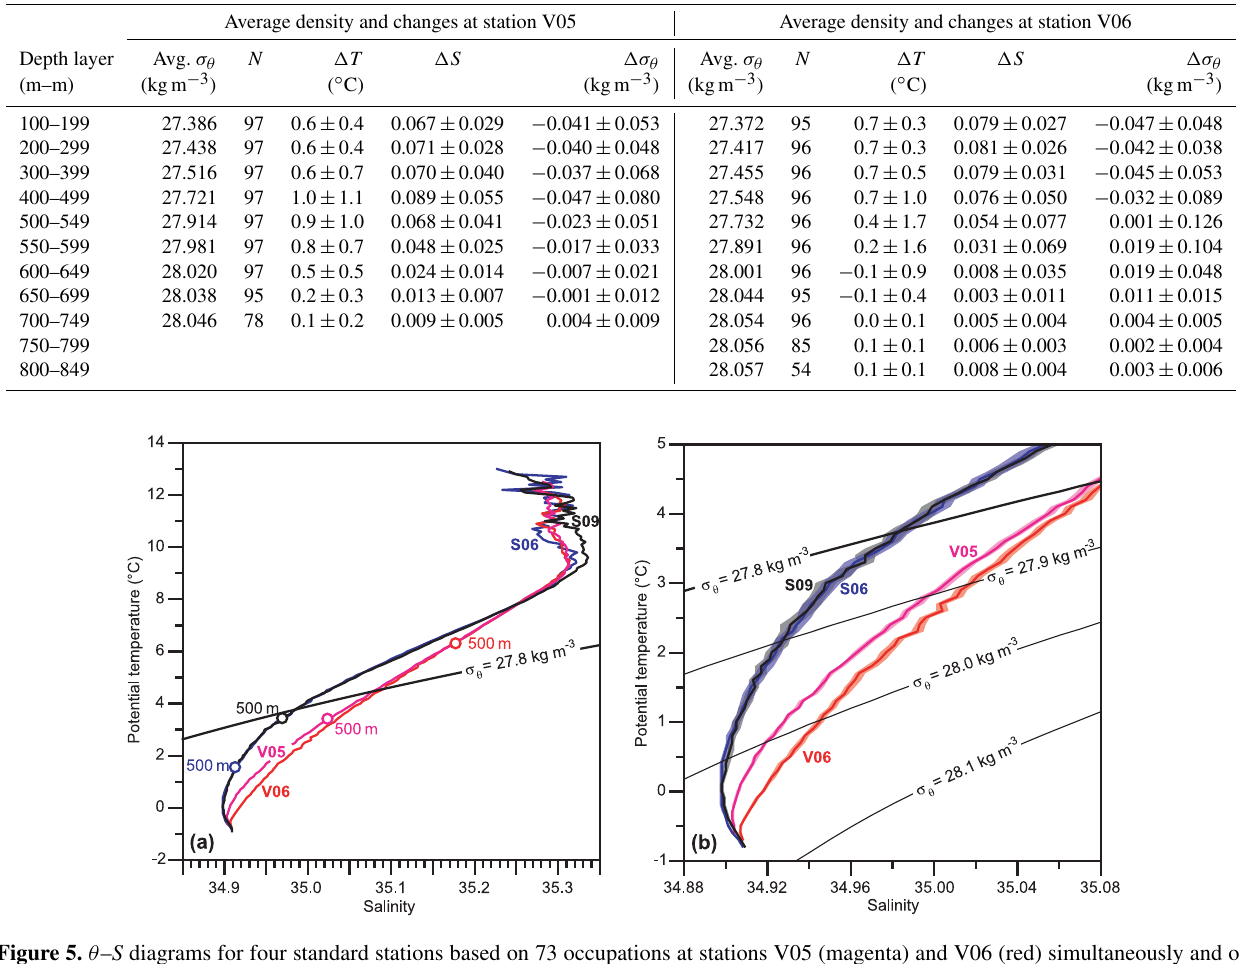
Figure 5. θ – S diagrams for four standard stations based on 73 occupations at stations V05 (magenta) and V06 (red) simultaneously and on 54 occupations at stations S06 (blue) and S09 (black) simultaneously in the period 1996–2010. (a) Average θ – S traces for the whole water column with conditions at 500m depth indicated by circles. (b) Expanded view of waters colder than 5 ◦ C with the average for each station shown as a colored line surrounded by a shaded area in the same color representing the average ± 1 standard error. Station locations are shown on Figs. 1 and